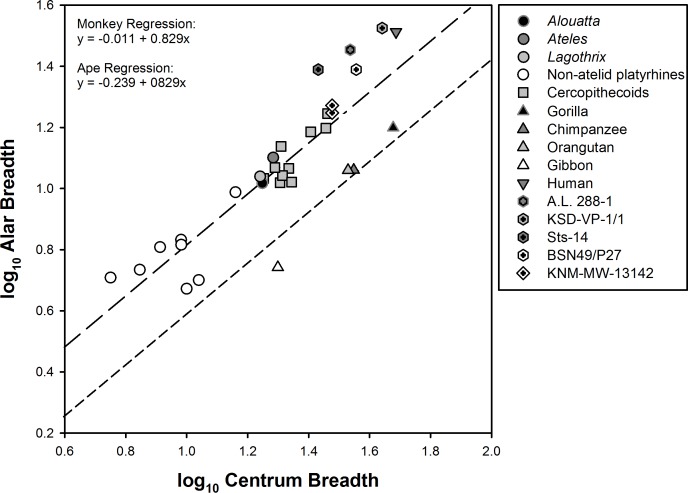
Relative sacral breadth in anthropoids.Sacral alar breadth compared to centrum breadth (for definitions see Fig. 2). Data represents genus means for extant taxa. Regression formulas are provided from a phylogenetic Analysis of Covariance (ANCOVA). Slopes do not differ significantly; however, there is a significant difference in elevation (p < 0.0001) between monkeys (long dashes) and apes (short dashes). Two points are plotted for Ekembo (KNM-MW-13142) representing the two alar breadth estimates discussed in the text. Hominids, including Au. afarensis (A.L. 288-1 and KSD-VP-1/1), Au. africanus (Sts-14), and H. erectus (BSN49/P27 Simpson et al., 2008) plot above the monkey regression line. The two non-atelid New World monkeys falling below the monkey regression line are Chiropotes santanas and Callicebus sp.